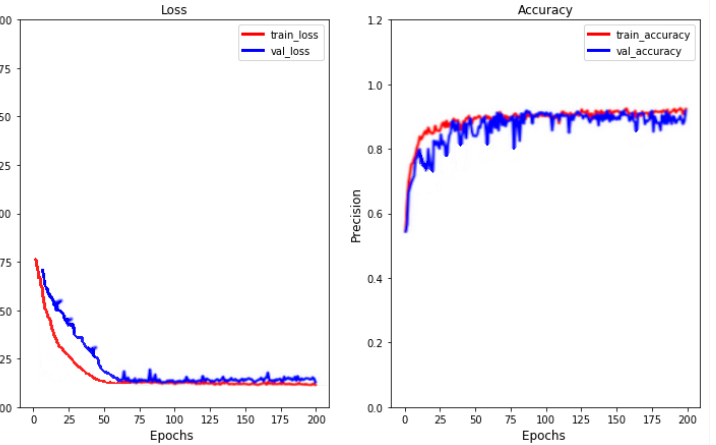
Figure 13. ( left ) Loss as a function of the epochs. ( right ) Accuracy reported by the model as a function of the